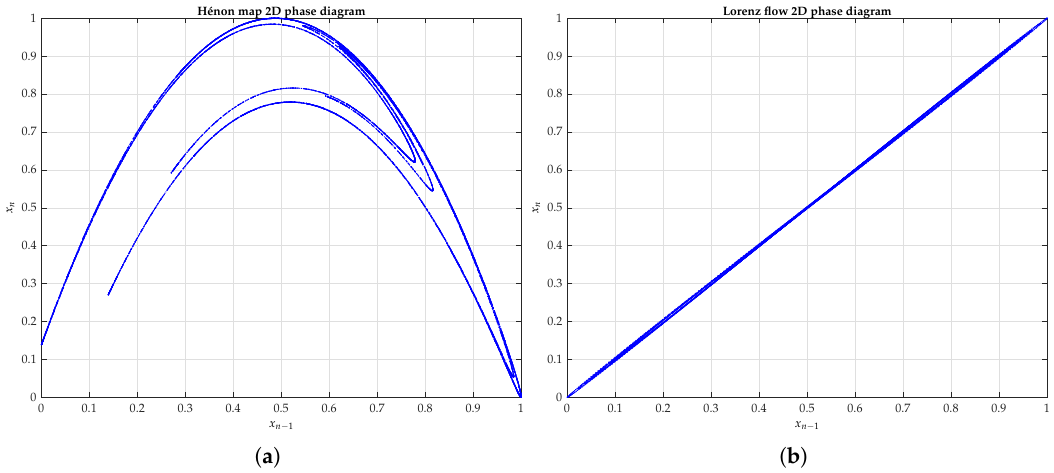
Figure 1. 2D phase diagram from the dynamic variable x of the: ( a ) Hénon map; and ( b ) Lorenz flow, with a sampling time of 2